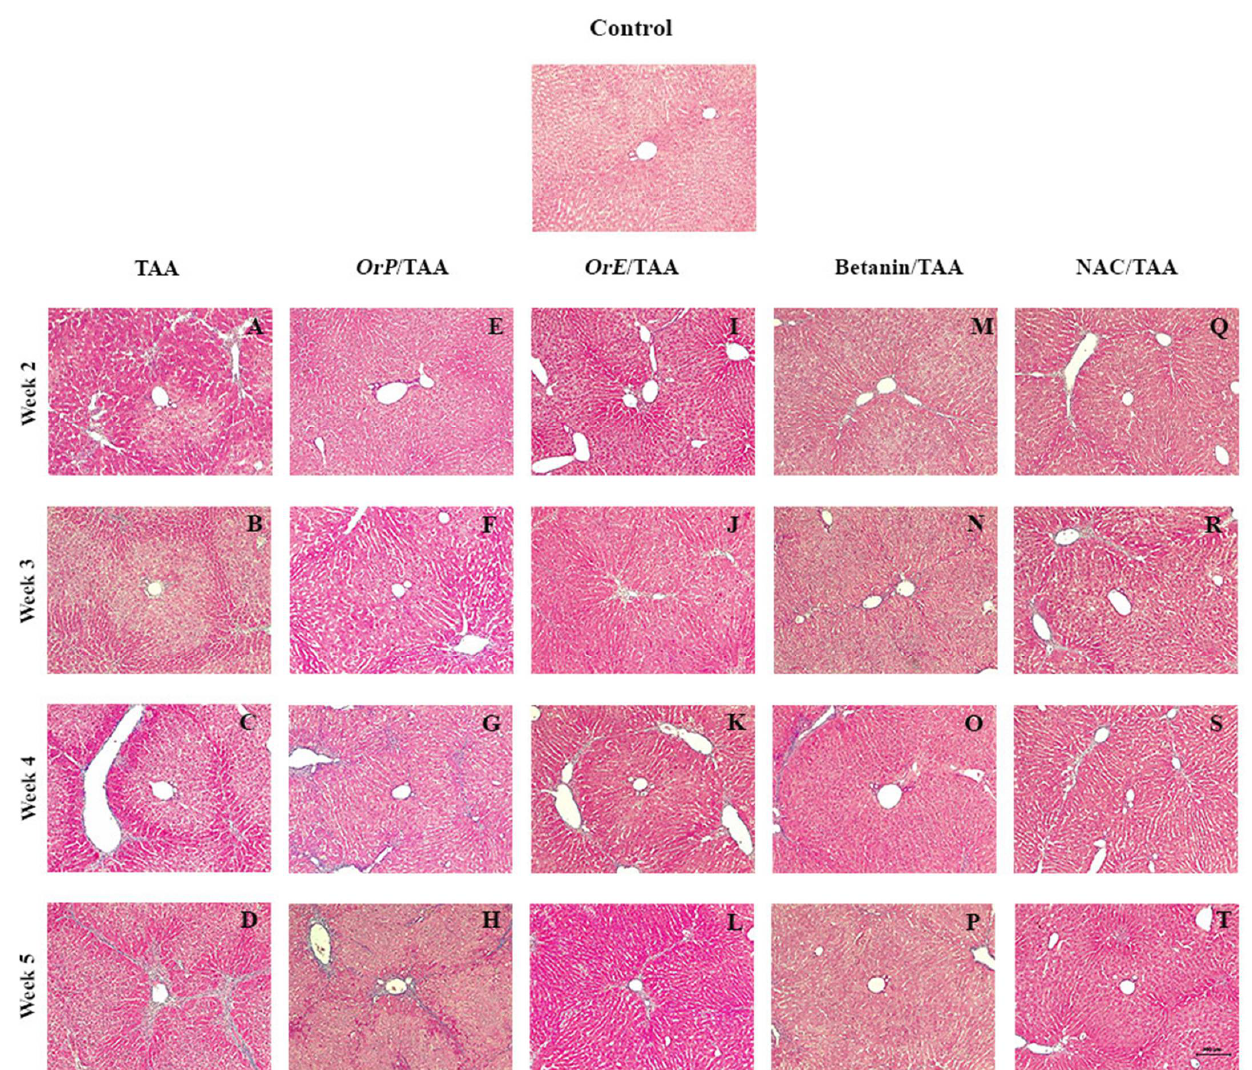
Figure 7. Damage projections from zone 3 to portal spaces. ( A – D ) Treatment with TAA showed extensive areas of vacuolation, necrosis, and fibrosis. Concomitant treatments decrease the severity of the damage. ( E – H ) OrP delays the morphological changes of the fibrotic process generated by TAA. ( I – T ) OrE, Betanin and NAC decrease the fibrotic process in all weeks of treatment. Masson’s trichrome staining. Magnification (100×).